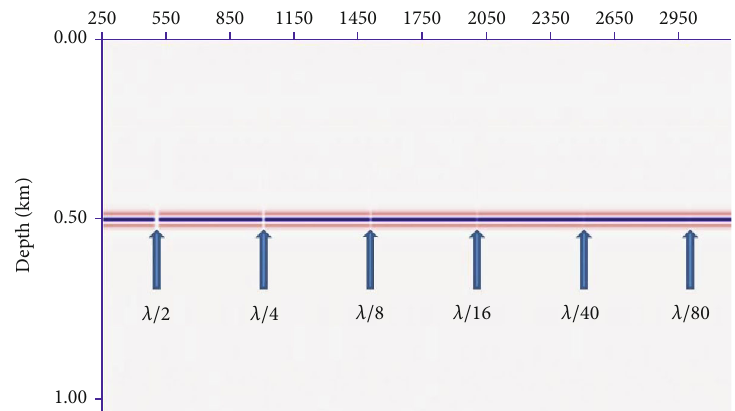
Figure 2: Forward model of the lens of di ff erent lateral scales.